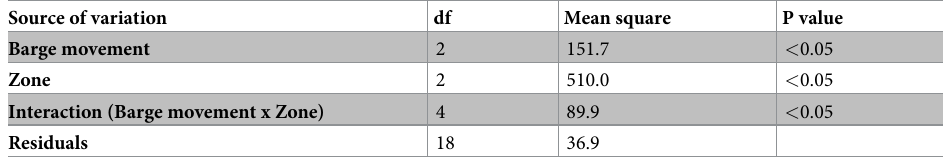
Table 3. Impact of ‘barge movement’ on plankton cell fragmentation in the river.